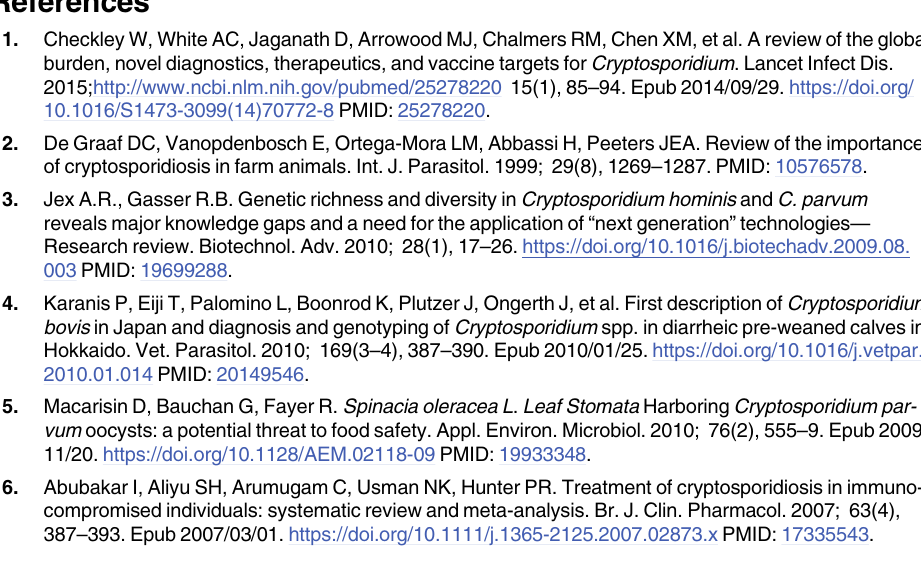
S5 Fig. In silico modeling of the docking of compound NSC10447 to human LDH. ( A ) Con- figuration of NSC10447 in the NADH (co-factor) binding site of human LDH (1I0Z). NSC10447 is shown as a stick model with bonds to carbon and oxygen depicted in gray and red, respectively. The various amino acid residues lining the pocket are also depicted as stick models (green and cyan). ( B ) Hydrogen bonding and hydrophobic residue contacts (between docked NSC10447 and human LDH’s NADH-binding site.